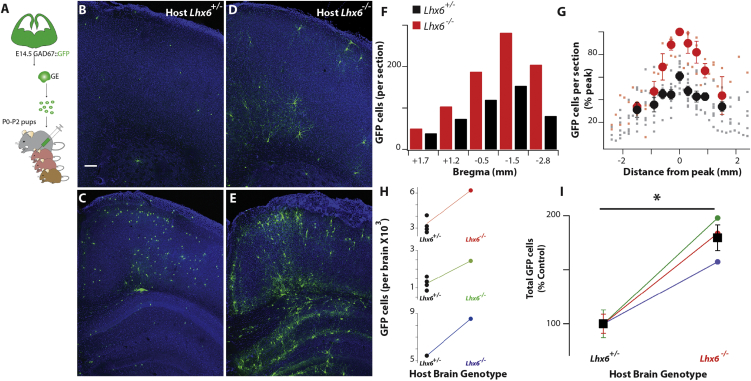
Cellular Microenvironment of Lhx6 Mutant Forebrain Promotes Grafted CI Progenitor Survival(A) Schematic representation of the CI progenitor transplantation into the cortex of P0–P2 pups.(B–E) Coronal brain sections of Lhx6+/− (B and C) and Lhx6−/− (D and E) P16 mice transplanted at P0–P2 with wild-type GFP+ CI progenitors. The sections shown in (B) and (D) are more anterior to those shown in (C) and (E).(F) Distribution of surviving GFP+ CIs in the cortex of an Lhx6+/− (black bars) and an Lhx6−/− (red bars) littermate pair of P16 mice grafted with CI precursors at P0–P2 at different rostro-caudal levels.(G) Distribution of GFP+ cells was similar in all cortices analyzed, with a peak in the presumed injection site. Regardless of the rostro-caudal level quantified, more GFP+ cells were present in Lhx6 mutant host cortices (red) than in their control littermates (black).(H and I) Quantification of surviving GFP+ CIs in the entire cortex of Lhx6+/− and Lhx6−/− P16 mice. In 3 independent experiments (H), the number of surviving GFP+ cells in the Lhx6 mutant host cortices was higher than that observed in control littermates grafted with the same cell suspension. (I) Values (taken from H) for the mutants (Lhx6−/−, circles) are normalized to the average value in control littermates (Lhx6+/−; colored bars represent SEM for individual grafting experiments that correspond to those in H). The number of GFP+ cells found in Lhx6−/− was 181% ± 13% higher in comparison with control littermates (p = 0.02, one sample t test, mean 100, n = 3 Lhx6−/− and 10 Lhx6+/−, minimum of 500 cells counted per brain).See Figure S5 for morphological characterization of wild-type GFP+ CI progenitors grafted in Lhx6 mutant brains. Scale bars are 100 μm.